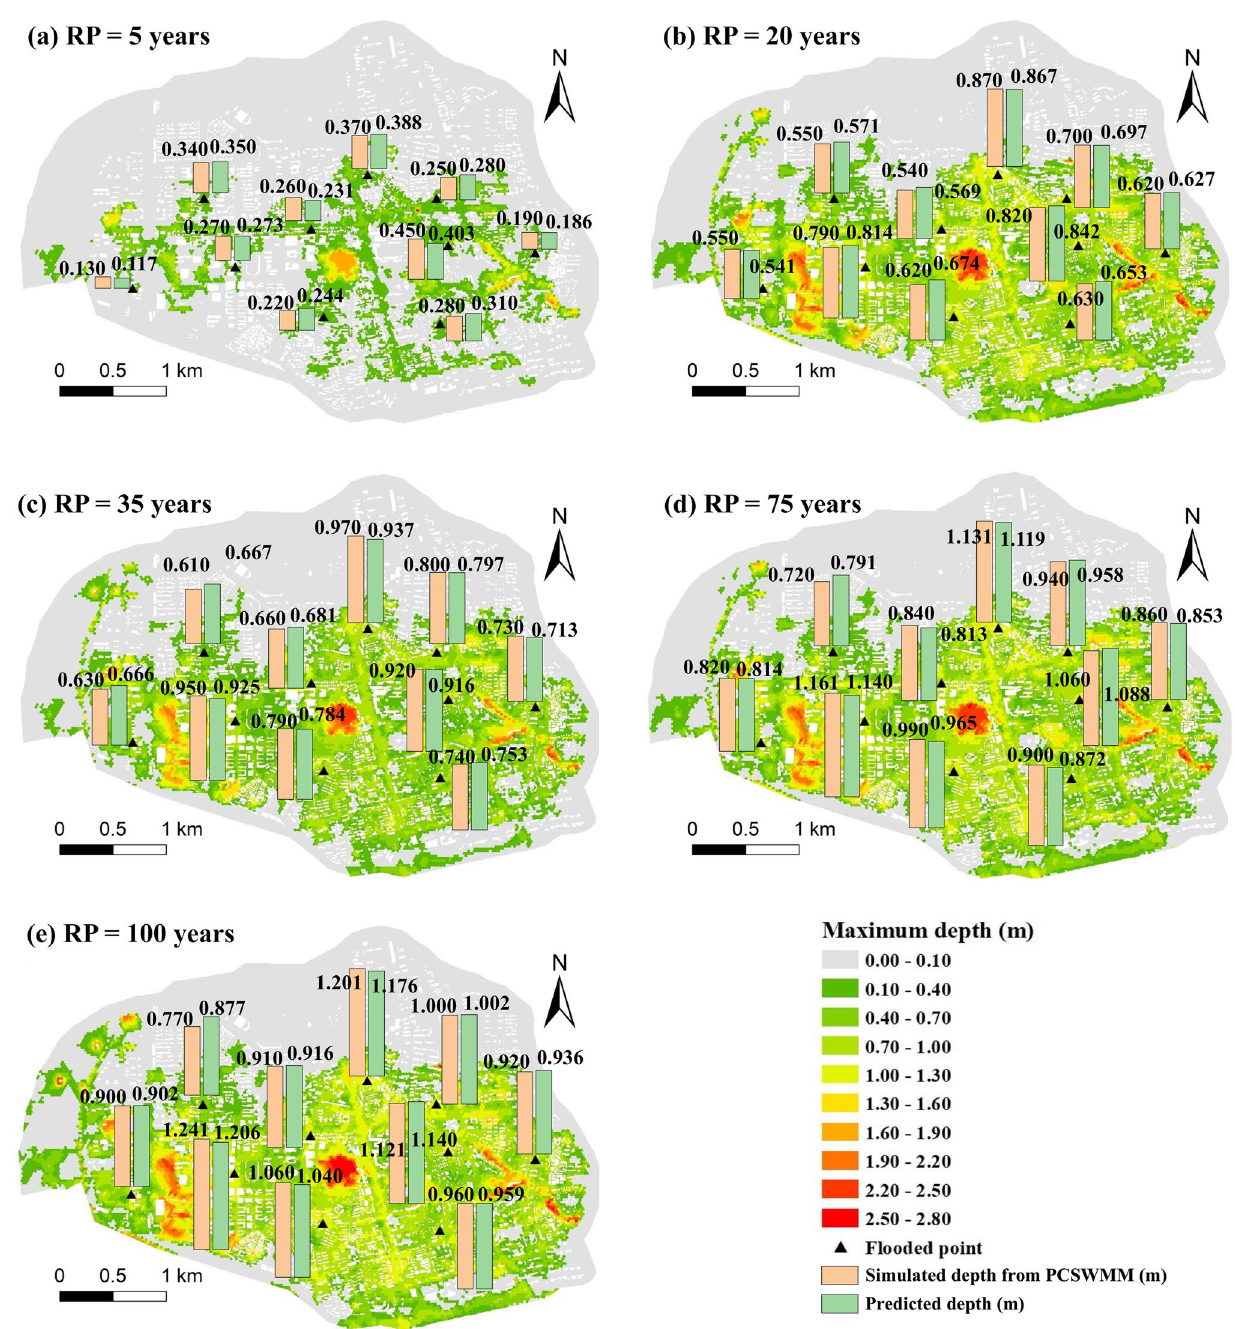
Fig. 11 Spatial distribution of simulated and predicted water depths in the Haidian Island study area on Hainan Island, China when the return periods of both rainfall and tide level are a 5 years, b 20 years, c 35 years, d 75 years, and e 100